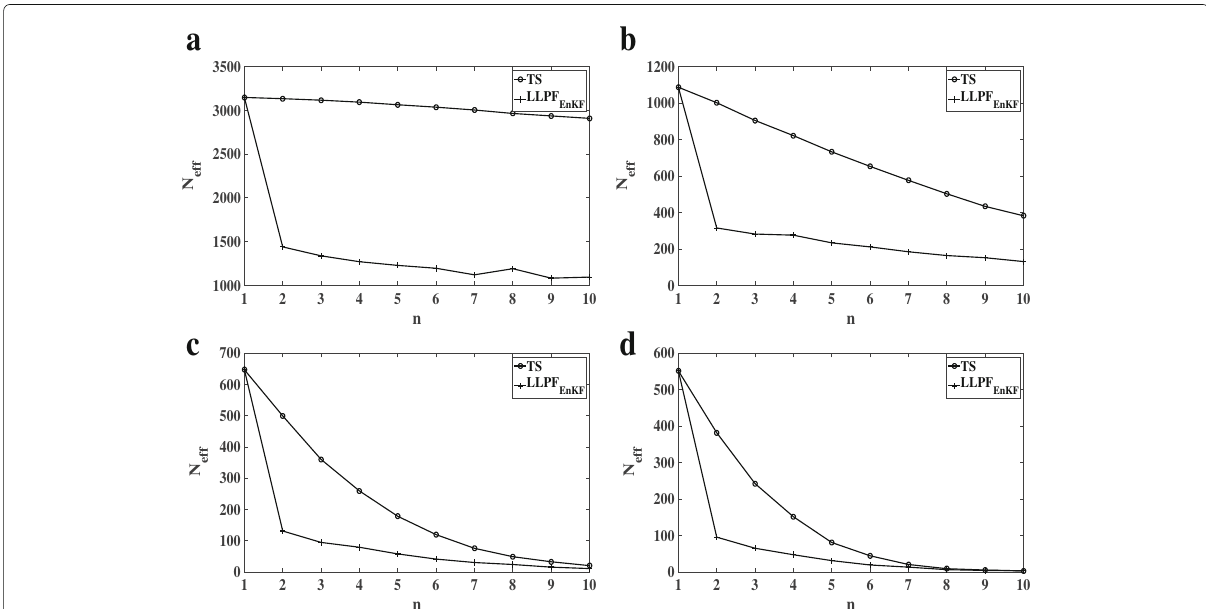
Fig. 5 Traceplots of average N eff , n of the TS and LLPF EnKF procedures based on N = 100 simulation experiments for Example 1 corresponding to four different ( Q , R ) specifications: a ( Q , R ) = ( 0.4,1 ) , b ( Q , R ) = ( 0.4,0.1 ) , c ( Q , R ) = ( 0.8,0.1 ) , and d ( Q , R ) = ( 1,0.1